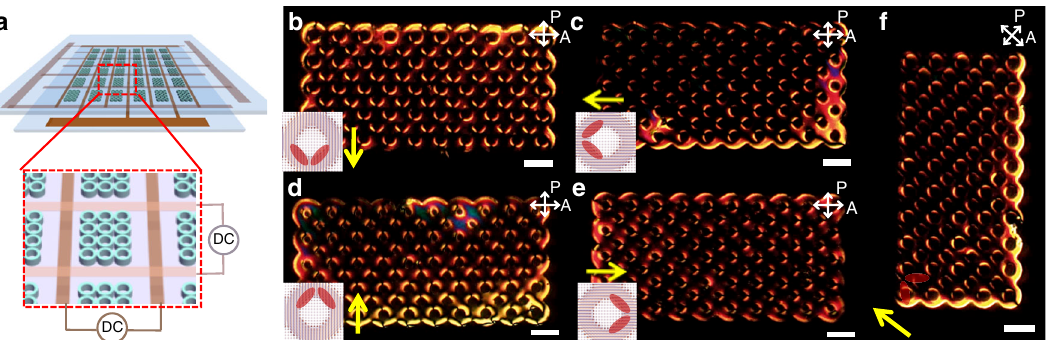
Fig. 6 Demonstration of a multistable device. a Device schematic showing electrodes and region of annuli. b – e Set of stable, cardinal states that may be switched into by the application of a small (0.5 V/ μ m) transverse, directional electric fi eld as indicated by each yellow arrow. Each of these states remains stable upon removal of the fi eld and any starting state can be used as a precursor to any chosen new state. f By careful tuning of the applied fi eld, the system can also access the four ordinal states, in which the defects reside along system diagonals. All scale bars are 20 μ m . Insets show the simulation con fi guration of Fig. 3e, with the distorted